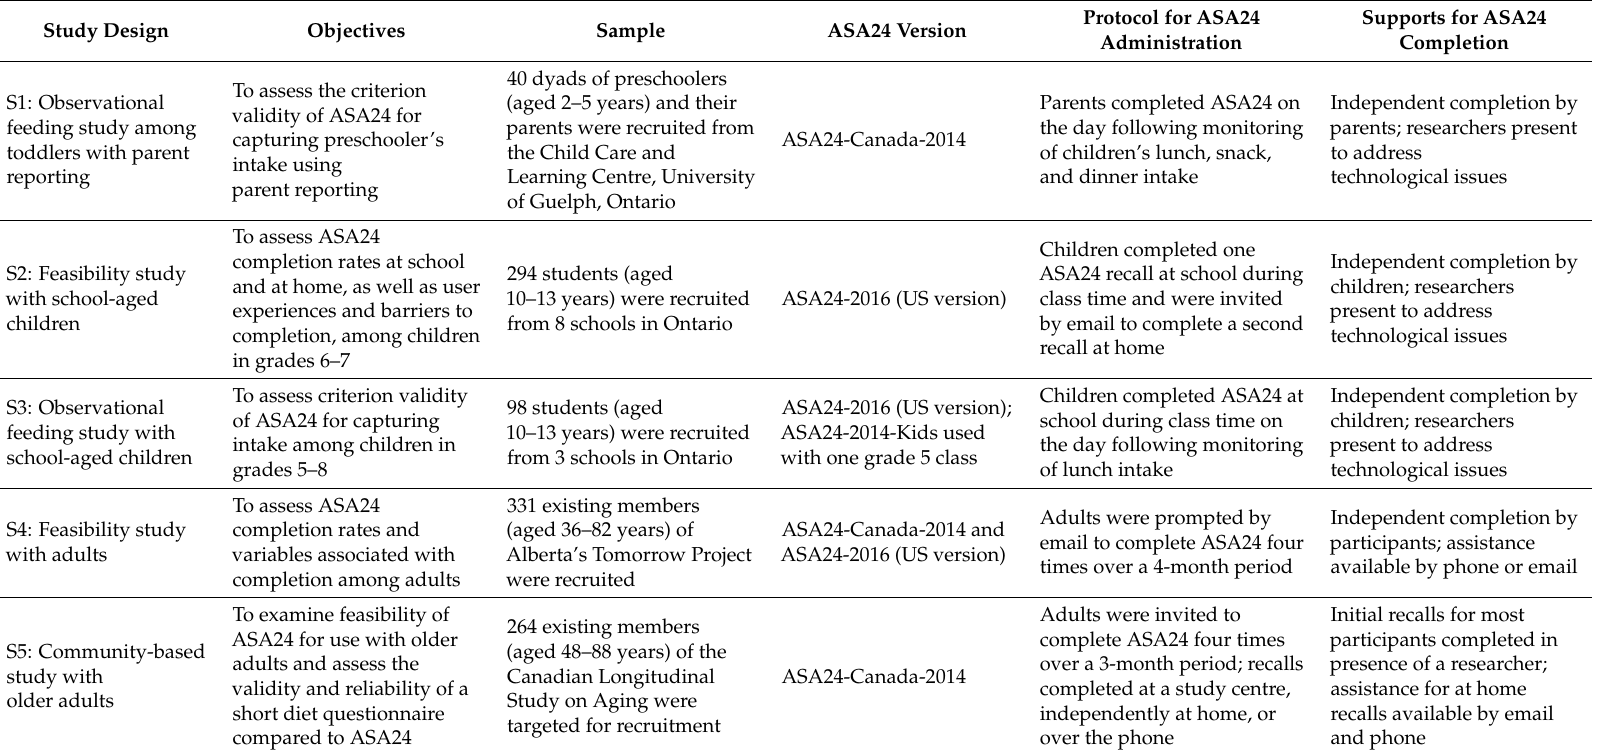
Table 1. Overview of methods used in five studies examining validity or feasibility of